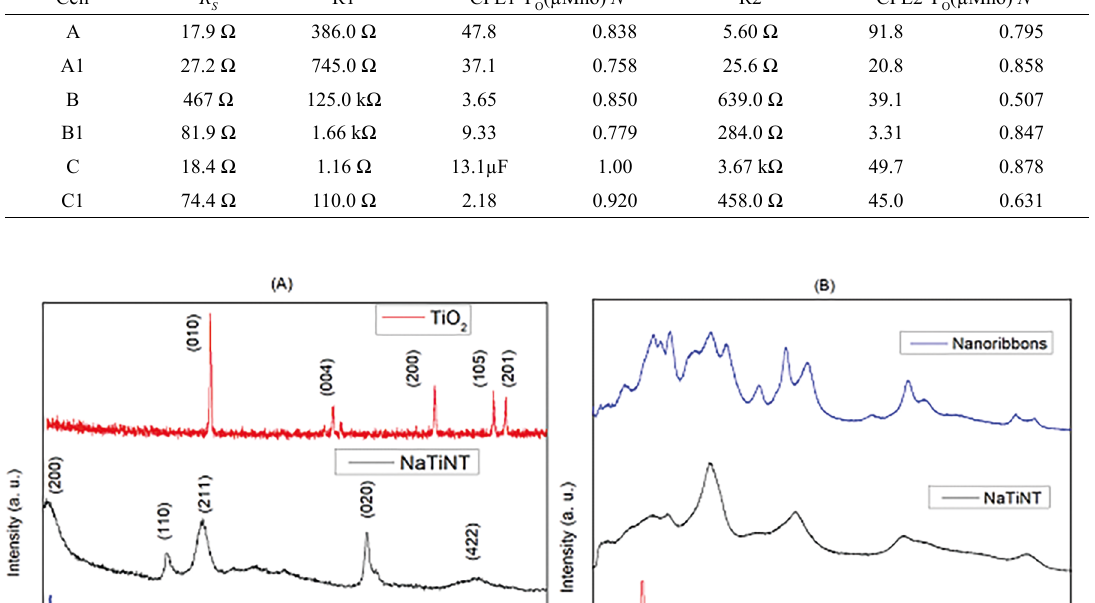
Table 2. Parameters for the circuit elements of the TiO (C) and Nanoribbons-450 °C